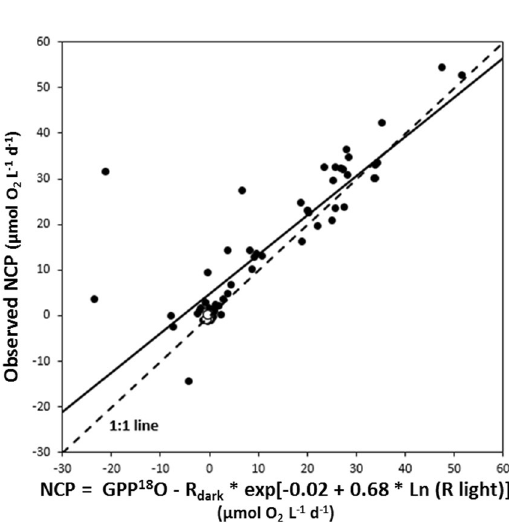
Figure 4. The relationship between gross primary production (GPP 18 O) and the difference between community respiration in the light and that in the dark (R light –R dark ) in the Svalbard region (black symbols) and in Young Sound (white symbols). The insert shows the same figure with log- transformed gross primary production (log GPP 18 O), to allow examination of the values at low GPP 18 O values.